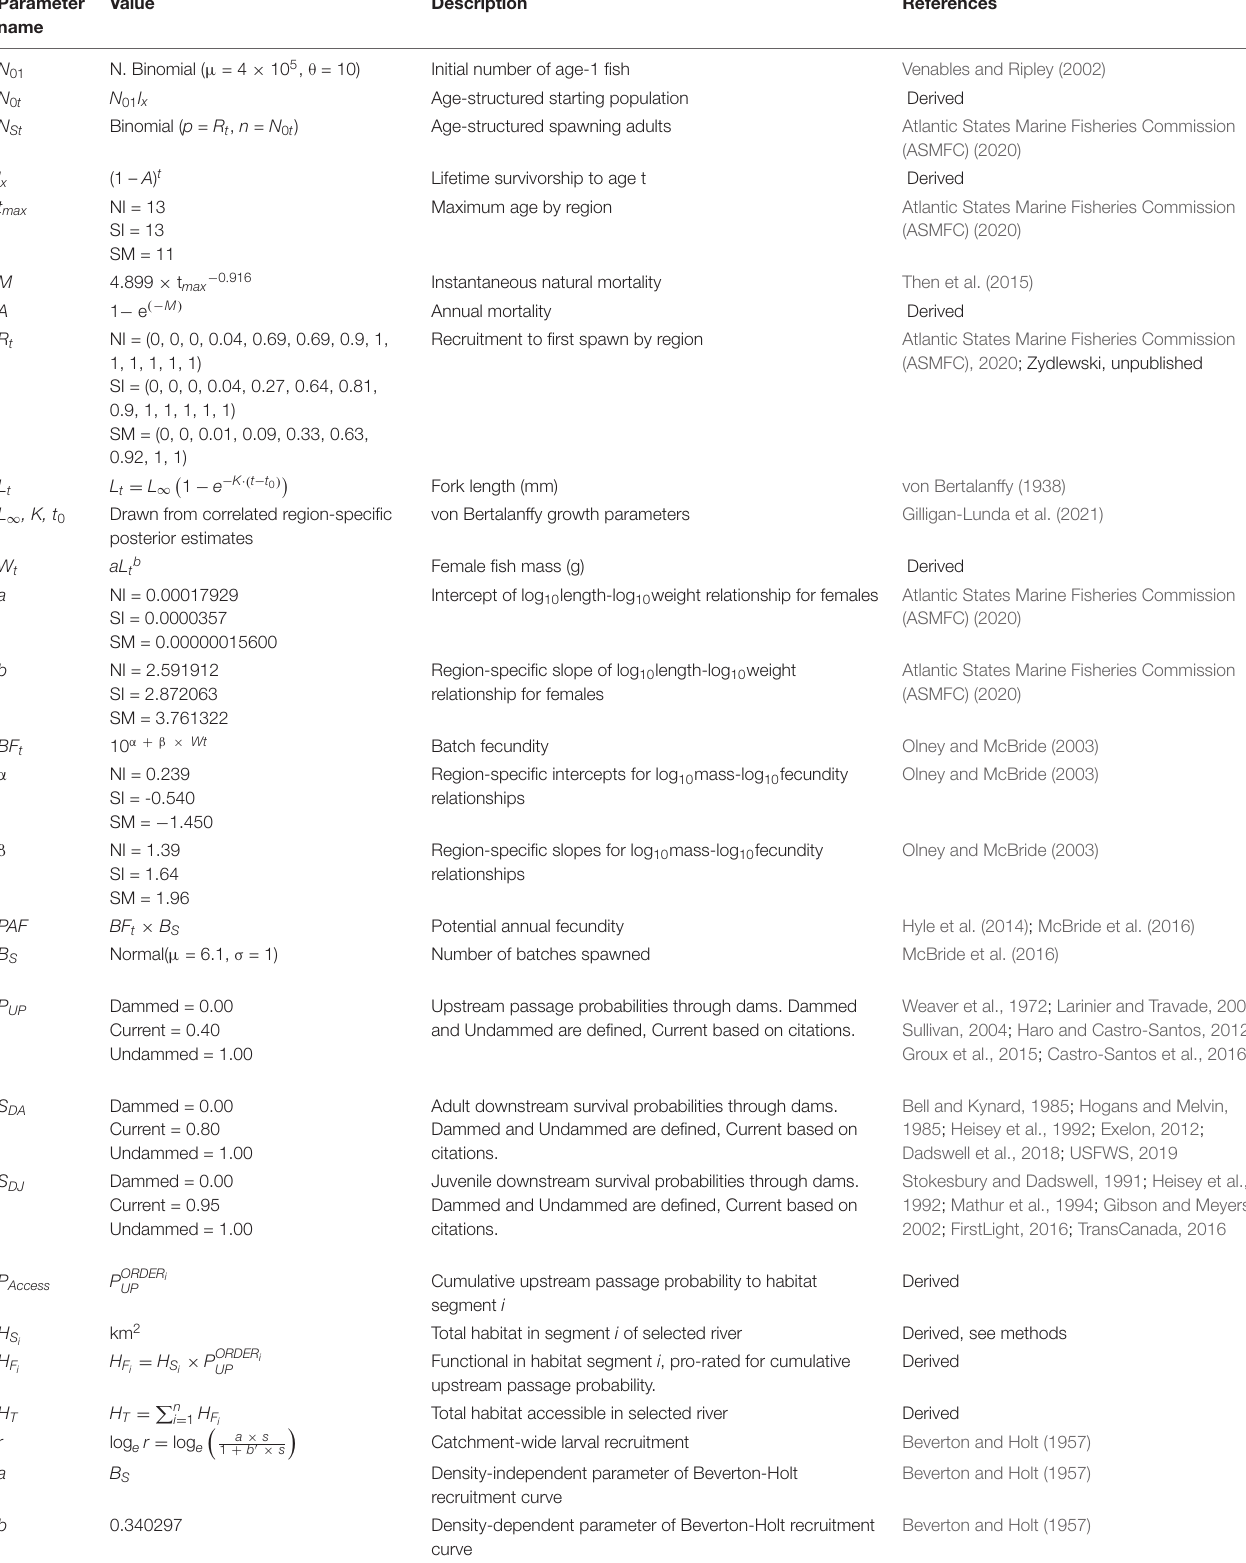
TABLE 1 | Parameter values for shad population model used to estimate the potential spawning run size for each river in the natural range of American